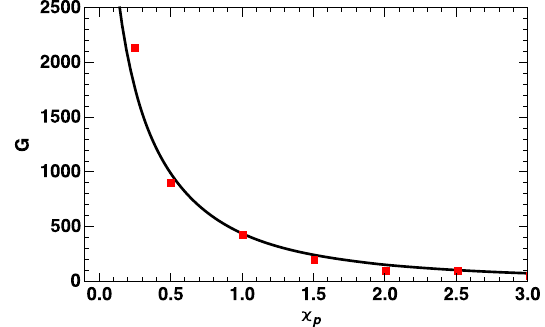
FIG. 10. Amplification factor of a small initial perturbation for two